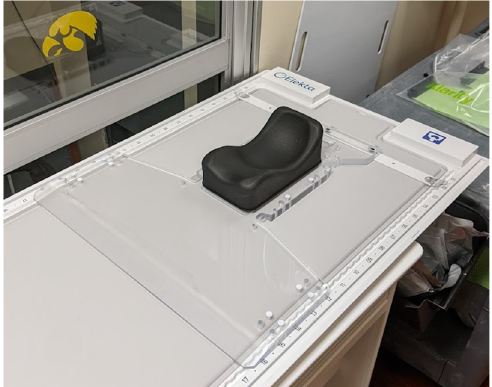
Figure 6. Custom acrylic baseplate for head-and-shoulder mask fixation and